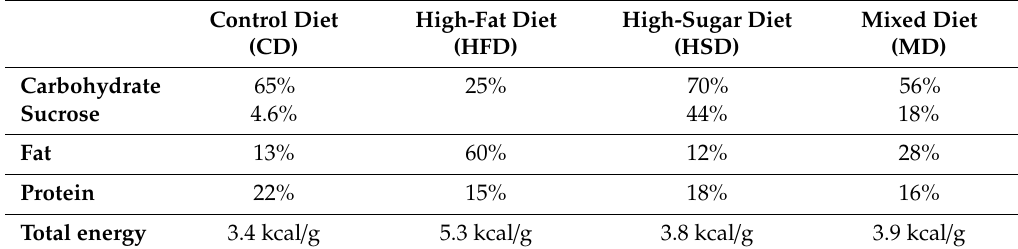
Table 1. Macronutrient profiles (expressed as a percentage of energy) and energy values of the control and modified diets used in this study.